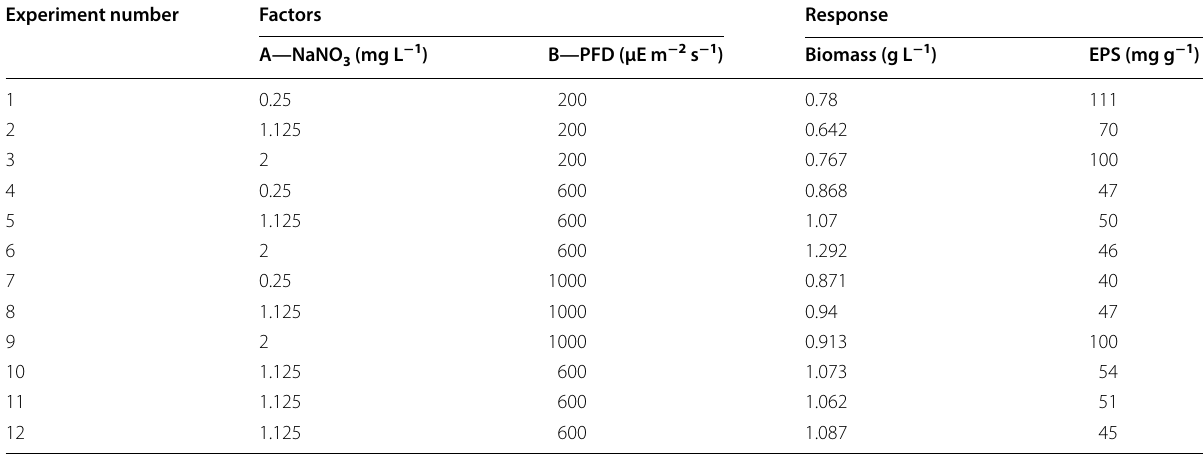
Table 1 Experimental matrix for EPS production with the corresponding variables and responses Experiment number Factors